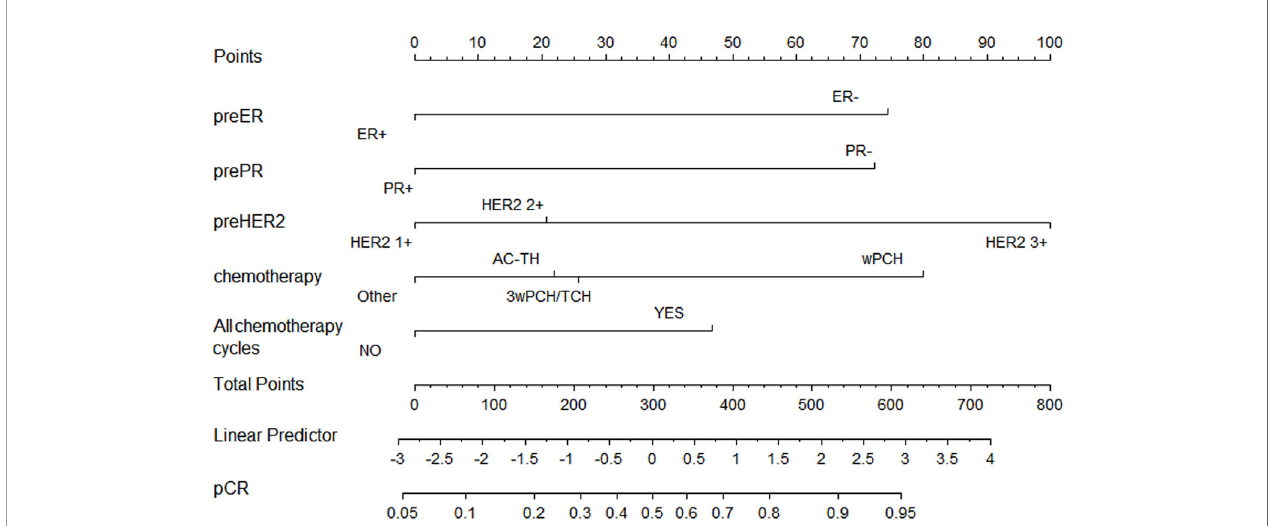
FIGURE 2 | Nomogram to predict pathological complete response after preoperative chemotherapy and trastuzumab for HER2 positive breast